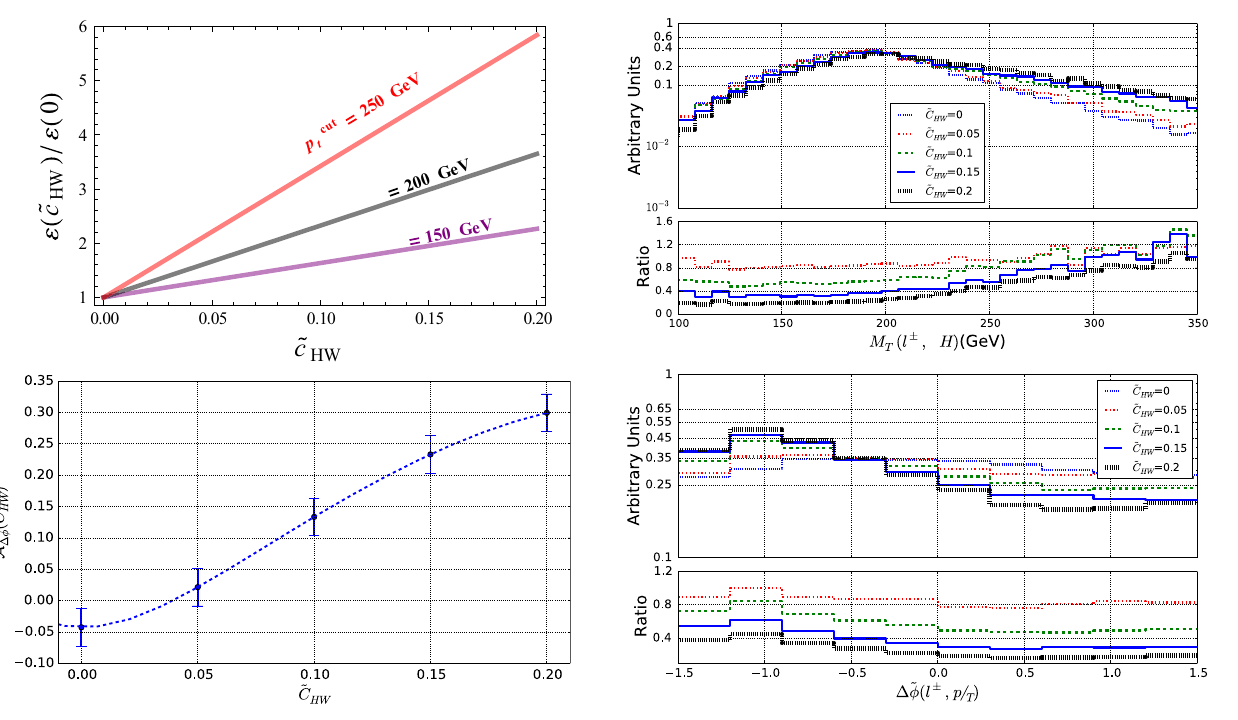
Fig. 7 Representative kinematical properties of the decay product of a Fig. 6 ˜ c HW dependence of the ε variable defined in Eq. (28) (left) for W H system produced in LHC collisions at a center-of-mass energy of different choices of the p cut threshold, and of the asymmetry defined in T 13 TeV. We consider the transverse mass of the W H system (top) and Eq. (29) (right) the angular separation in azimuth between the lepton and the missing momentum (bottom). We allow for different values for the ˜ c HW param- eter and we present, in the lower panels, the bin-by-bin ratio of the new physics predictions to the Standard Model